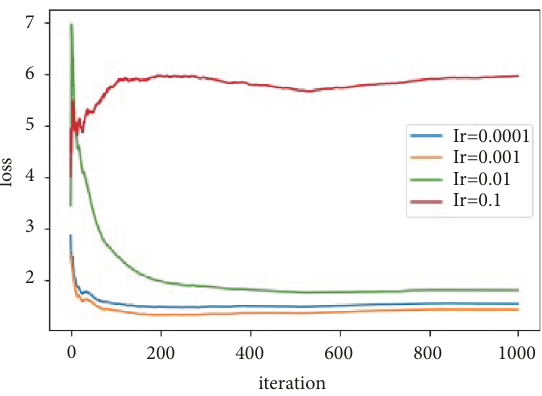
Figure 4: Divergence of different learning